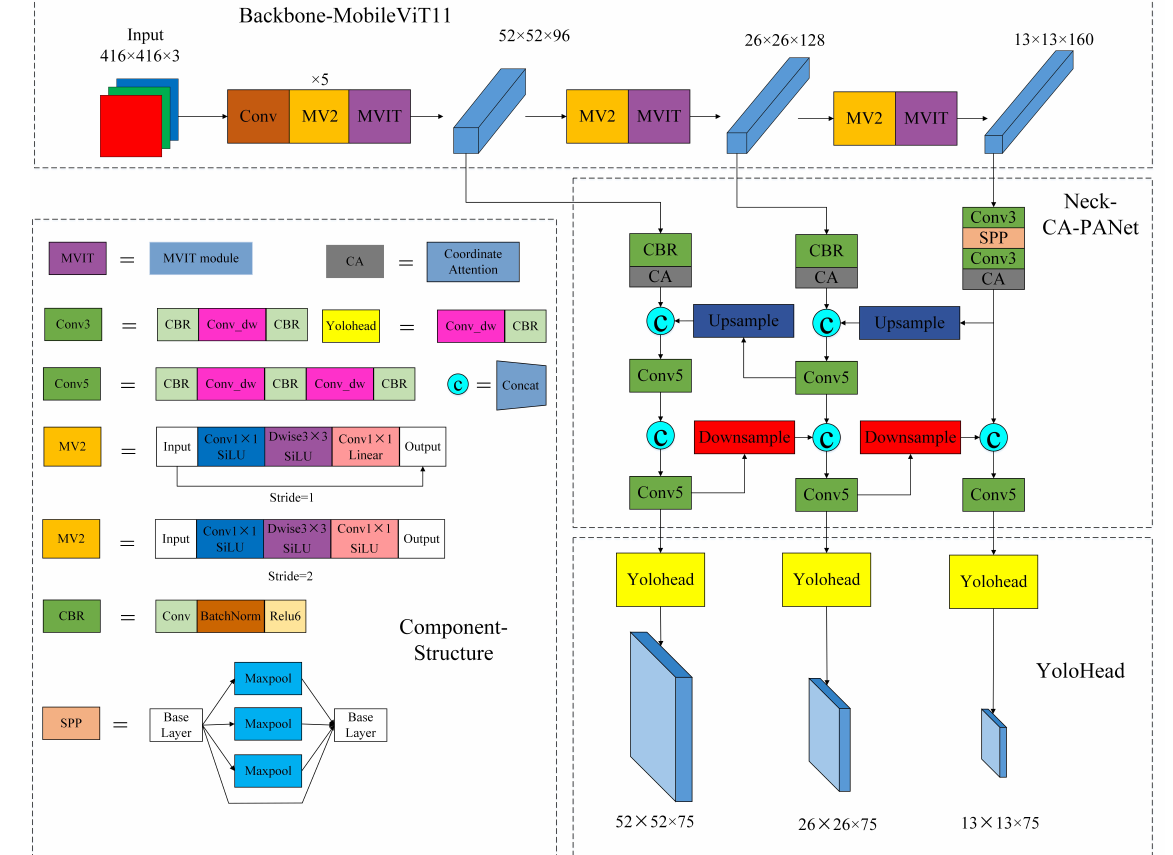
Figure 1. YOLOv4-MCA model architecture